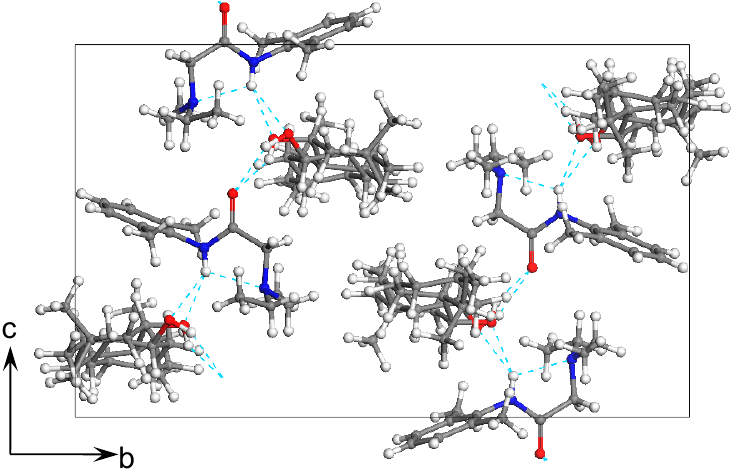
Figure 3. Crystal structure of the lidocaine: DL -menthol cocrystal. Hydrogen bonds are indicated by